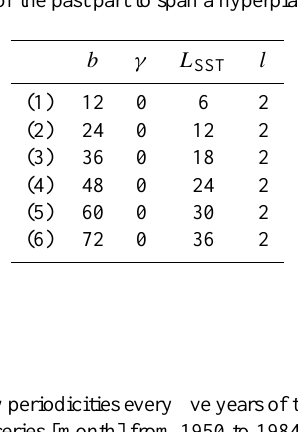
Table 5. Monthly periodicities every five years of the representative harmonics time series [month] from 1950 to 1984. The main peri- odicities in Nakuru, Naivasha, and Kisumu transiently change from annual cycle to semiannual cycle in the 1960s. Time region Nakuru Naivasha Narok